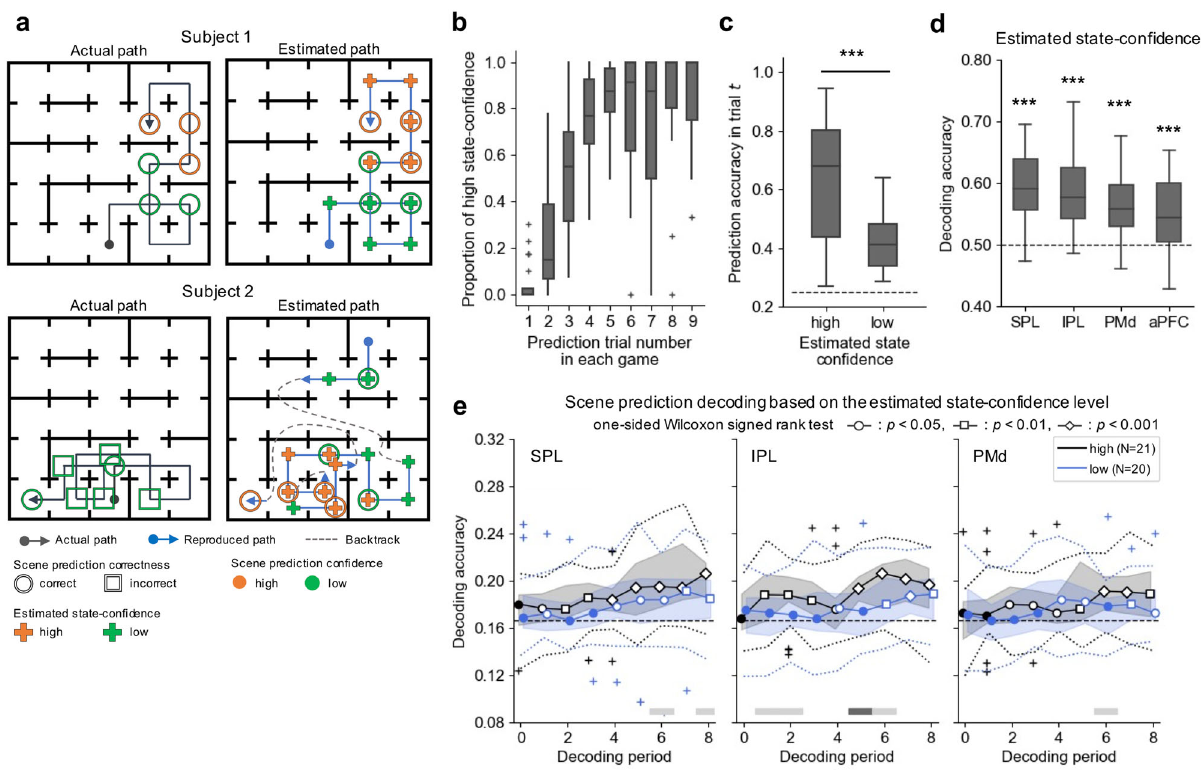
Fig. 4 Results of behavioral and decoding analyses based on the computational model of human navigation. a Examples of subjects ’ actual behaviors in the maze (left panels) and estimated behaviors using a hidden Markov model (HMM) with the maximum a posteriori probability estimate (right panels). Subject 1 and Subject 2 are representative examples of good and poor performances, respectively. The arrows represent the actual (black) and estimated paths (blue), starting from unknown initial positions ( fi lled circles). The dashed lines on the estimated path indicate the subject ’ s position before and after the HMM inferred that the subject had re-estimated their position due to a discrepancy between the expected and observed scenes. The circle or square markers signify the positions in which the subject made a correct or incorrect scene prediction, respectively, and the color corresponds to the subject ’ s reported con fi dence level about the scene prediction in that position (green: low, orange: high). The color of the cross-markers in the right panels represents the con fi dence level about the current state estimated by the HMM (green: low, orange: high). b Proportion of trials with a high state- con fi dence level as a function of the prediction trial number in each game. The proportion of the trials in which the HMM estimated the subjects ’ con fi dence level as high increased as the number of prediction trials performed in a single game increased ( r = 0.63, p = 2.6 × 10 − 28 ). Each box extends from the lower to upper quartiles with a horizontal line at the median. The whiskers represent 1.5 × IQR. The cross-markers indicate the outliers. c Scene prediction accuracies compared between trials with high and low state-con fi dence levels estimated by the HMM. The prediction accuracy was signi fi cantly higher when the HMM estimated the con fi dence level is high compared to low (one-sided Wilcoxon signed-rank test, ***: p < 0.001). The dashed line indicates chance level. d Decoding accuracy of the HMM estimated state con fi dence. The decoding accuracy was evaluated using LOSO CV (one-sided Wilcoxon signed-rank test, ***: p < 0.001). The dashed line indicates the chance level. Here we plotted the result for the 6th decoding period representatively; the results of our time-series decoding analysis are shown in Supplementary Fig. 7c. e Time-series decoding accuracies of scene prediction for different state-con fi dence levels. Each decoder for each period was trained with the trials of high (or low) state con fi dence estimated by the HMM, and the accuracy was evaluated by LOGO CV. The solid lines represent the median, shaded areas indicate the range between the upper and lower quartiles, and the dotted lines indicate the range of 1.5 × IQR. Cross-markers indicate the outliers. Signi fi cance was tested using a one-sided Wilcoxon signed-rank test (un fi lled circle: p < 0.05, un fi lled square: p < 0.01, un fi lled diamond: p < 0.001) compared to the chance level (dashed line). The colors of the horizontal line below the plots re fl ect the signi fi cant differences between the two categories of the trials in each decoding period (one-sided Wilcoxon rank-sum test, light gray: p < 0.05, dim gray: p <